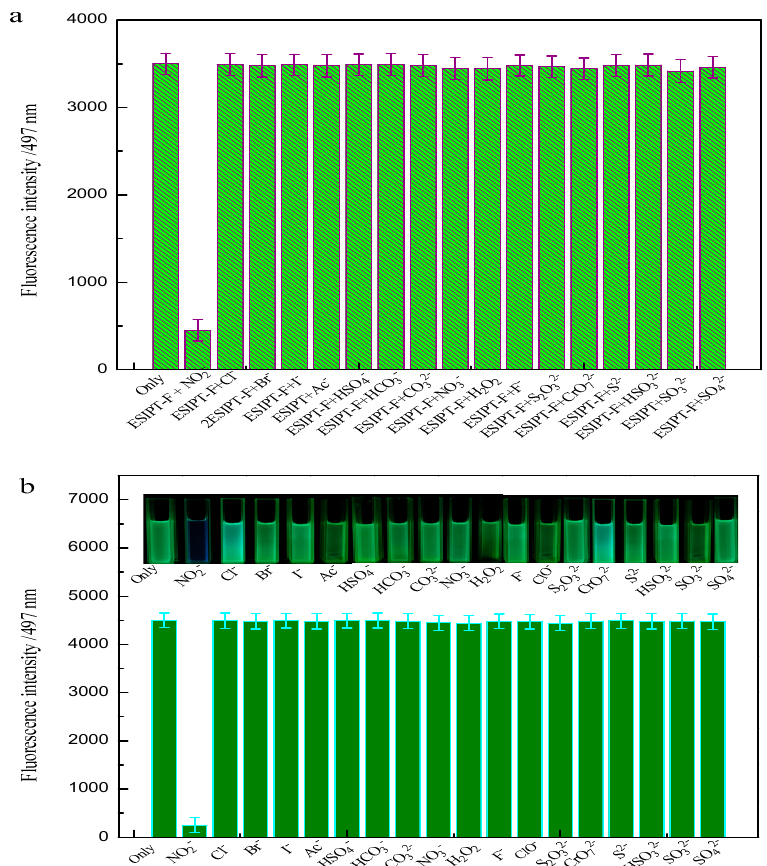
Figure 6. ( a ) Anti-interference ability of the probe ESIPT-F (10 μ M) in the presence of different anions and oxidants in DMF-HEPES solutions ( v / v = 4/1, pH 6.5); ( b ) Anion selectivity of ESIPT-F to different ions in DMF-HEPES solutions ( v / v = 3/1, pH 6.5). The anion concentrations are 0.5 μ M; λ ex = 365 nm, λ em = 497 nm.